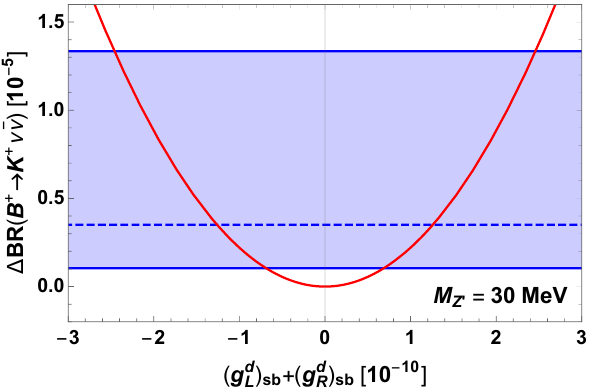
Figure 3 . The red curve shows our prediction of (cid:1)BR( B + ! K + (cid:23) (cid:22) (cid:23) ) with M Z 0 = 30 MeV. The blue dashed line is the central value of the experimental result eq. (3.15) and the shaded area shows 1 : 64 (cid:27) allowed region from (cid:1)BR( B + ! K + (cid:23) (cid:22) (cid:23) ) exp